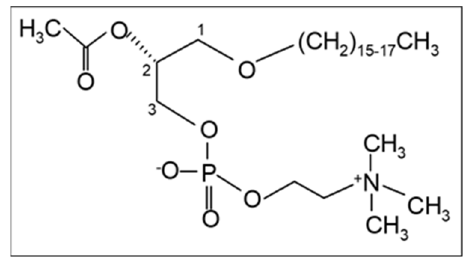
Figure 1. The chemical structure of Platelet-Activating Factor, PAF (1-O-alkyl-2-acetyl- sn -glycero- 3-phosphocholine).